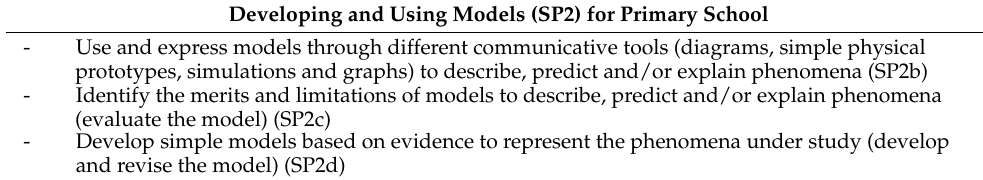
Table 3. Indicators for the analysis of scientific practices adapted from NRC